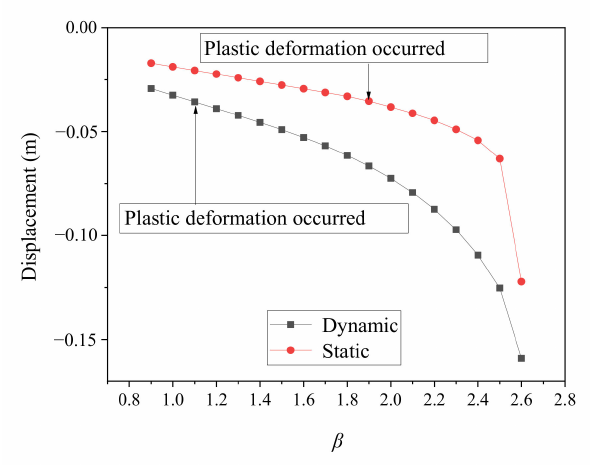
Figure 22. Maximum vertical displacement versus β in the dynamic and static